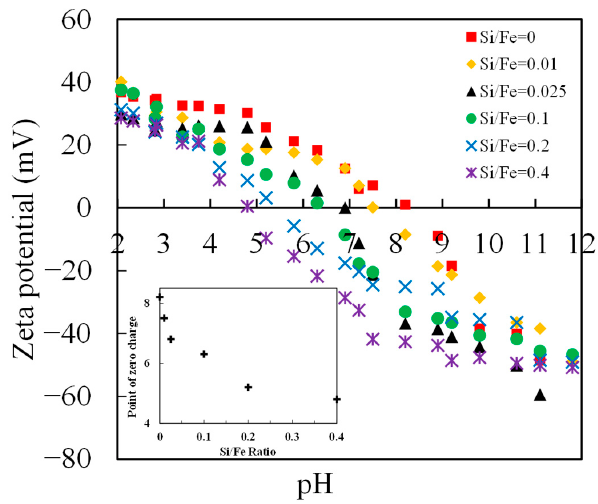
Figure 3. Changes in the ζ -potential of ferrihydrite at different Si/Fe ratios as a function of pH in 0.01 M NaCl.